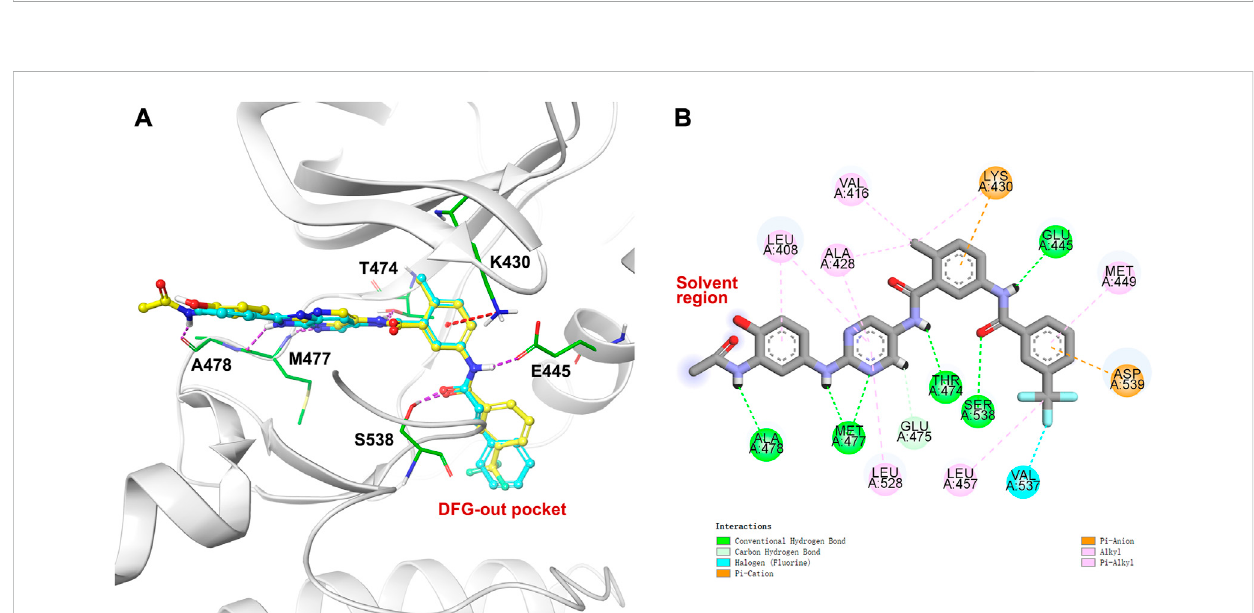
FIGURE 3 MoleculardockingagainstkinasedomainofBTK: (A) Thebindingmodeofcompound 4 (carboninyellow)intheDFG-outconformationofBTK(PDB ID: 3pj3), and superimposition with the co-crystallized ligand 1 (carbon in cyan). Hydrogen bonds are visualized as dashed purple lines, π -cation interactions are visulalized as dashed red lines. (B) 2D diagram of interactions between compound 4 and